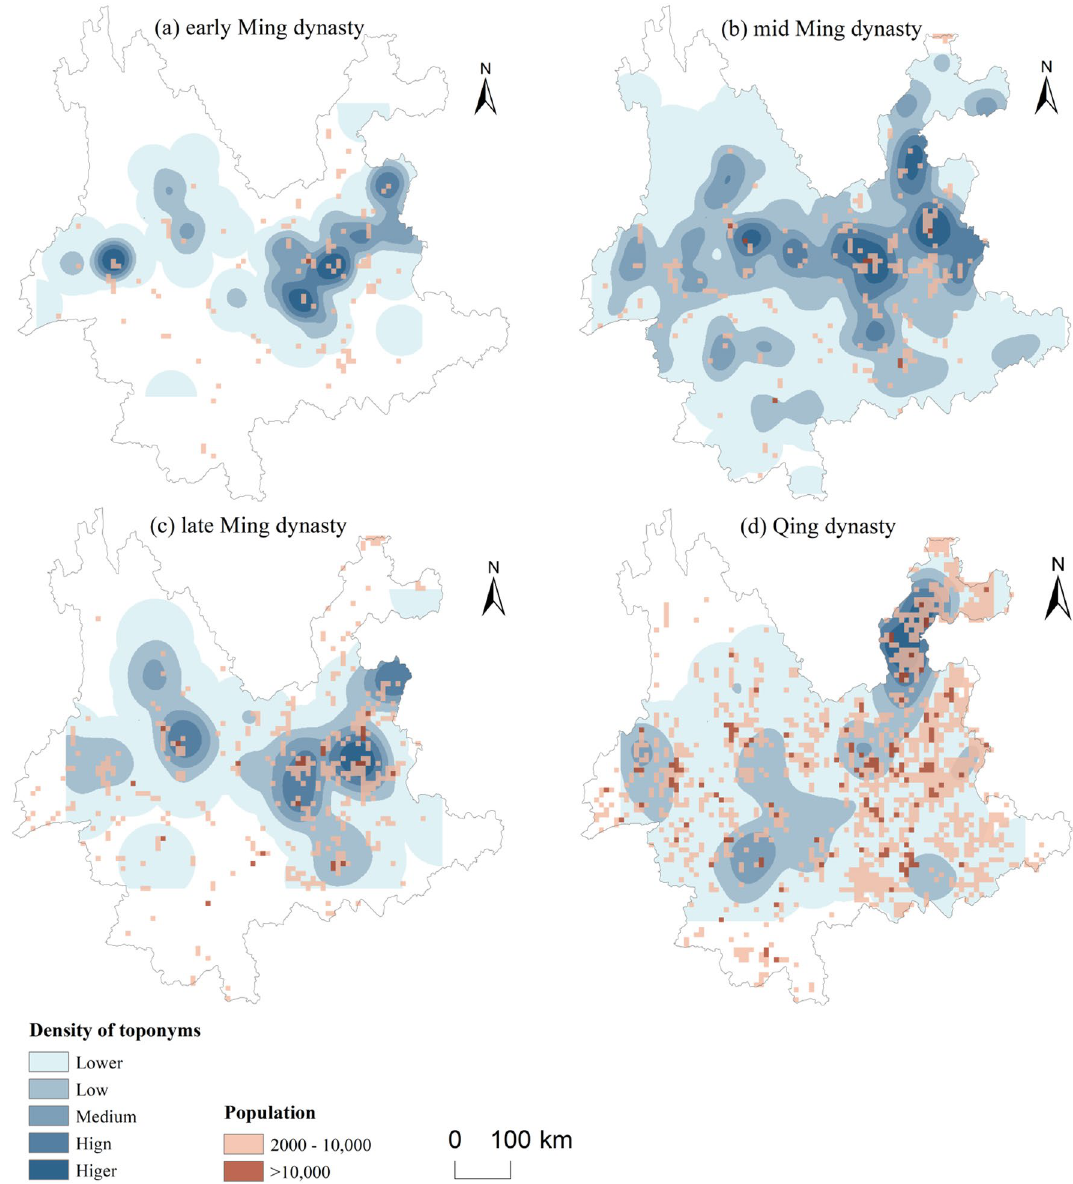
Figure 6. Spatiotemporal evolution of Biantun toponyms (BTT) and population in Yunnan Province. Maps were created in ArcGIS Pro v.2.7: https:// www. esri. com (Esri, California, USA). The final layout was created in ArcGIS Pro v.2.7: https:// www. esri. com (Esri, California,